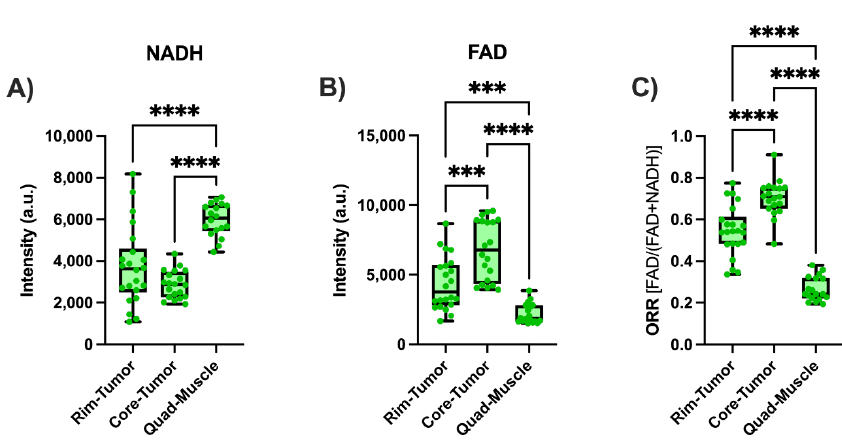
Figure 7. Redox indices in tumor rim and core and muscle. ( A ) NADH, ( B ) FAD, and ( C ) ORR readings for MDA-MB-231 malignant tumors and mouse quadricep tissue. (*** = [0.001 ≥ p > 0.0001], **** = [0.0001 ≥ p ]).